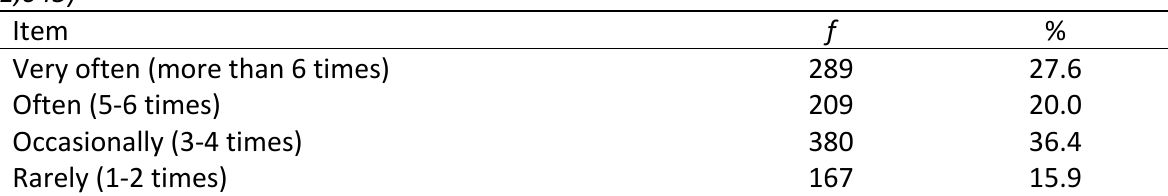
Frequency People Shared Information about COVID-19 in the First Month of the Pandemic (n = 1,045)